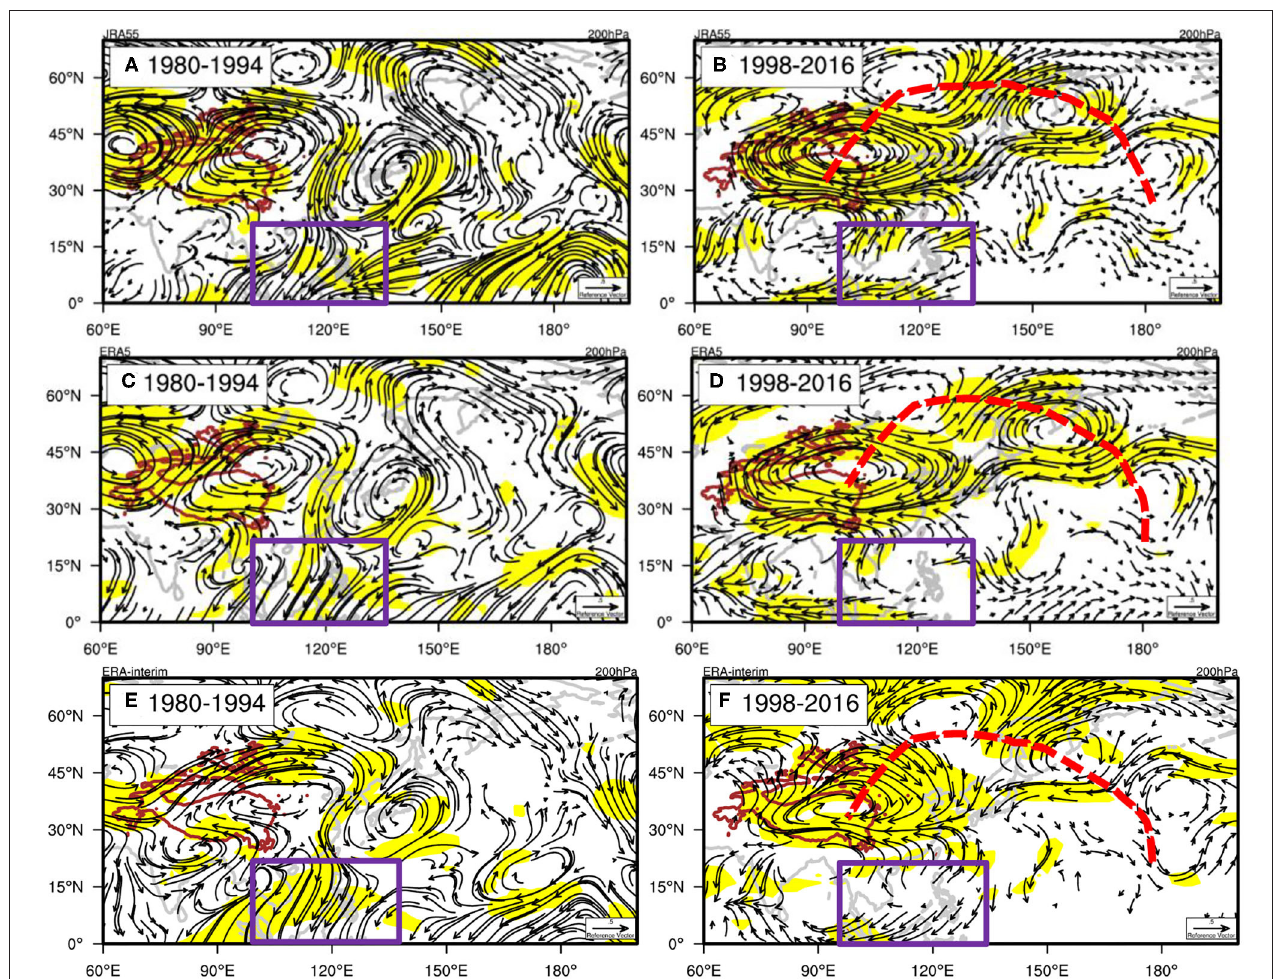
FIGURE 8 | Standardized partial regression coefficients between Tibetan Plateau temperature and wind field at 200 hPa in East Asia: (A,C,E) for the period from 1980 to 1994 and (B,D,F) for the period from 1998 to 2016. (A,B) Based on JRA55; (C,D) based on ERA5; and (E,F) based on ERA-Interim. Red solid line represents the Tibetan Plateau. The purple boxed areas represent the South China Sea. Red dashed lines represent wave-like structures. Vectors are ignored for values < 0.20. Shading indicates significant differences above the 90% confidence level based on the Student’s t